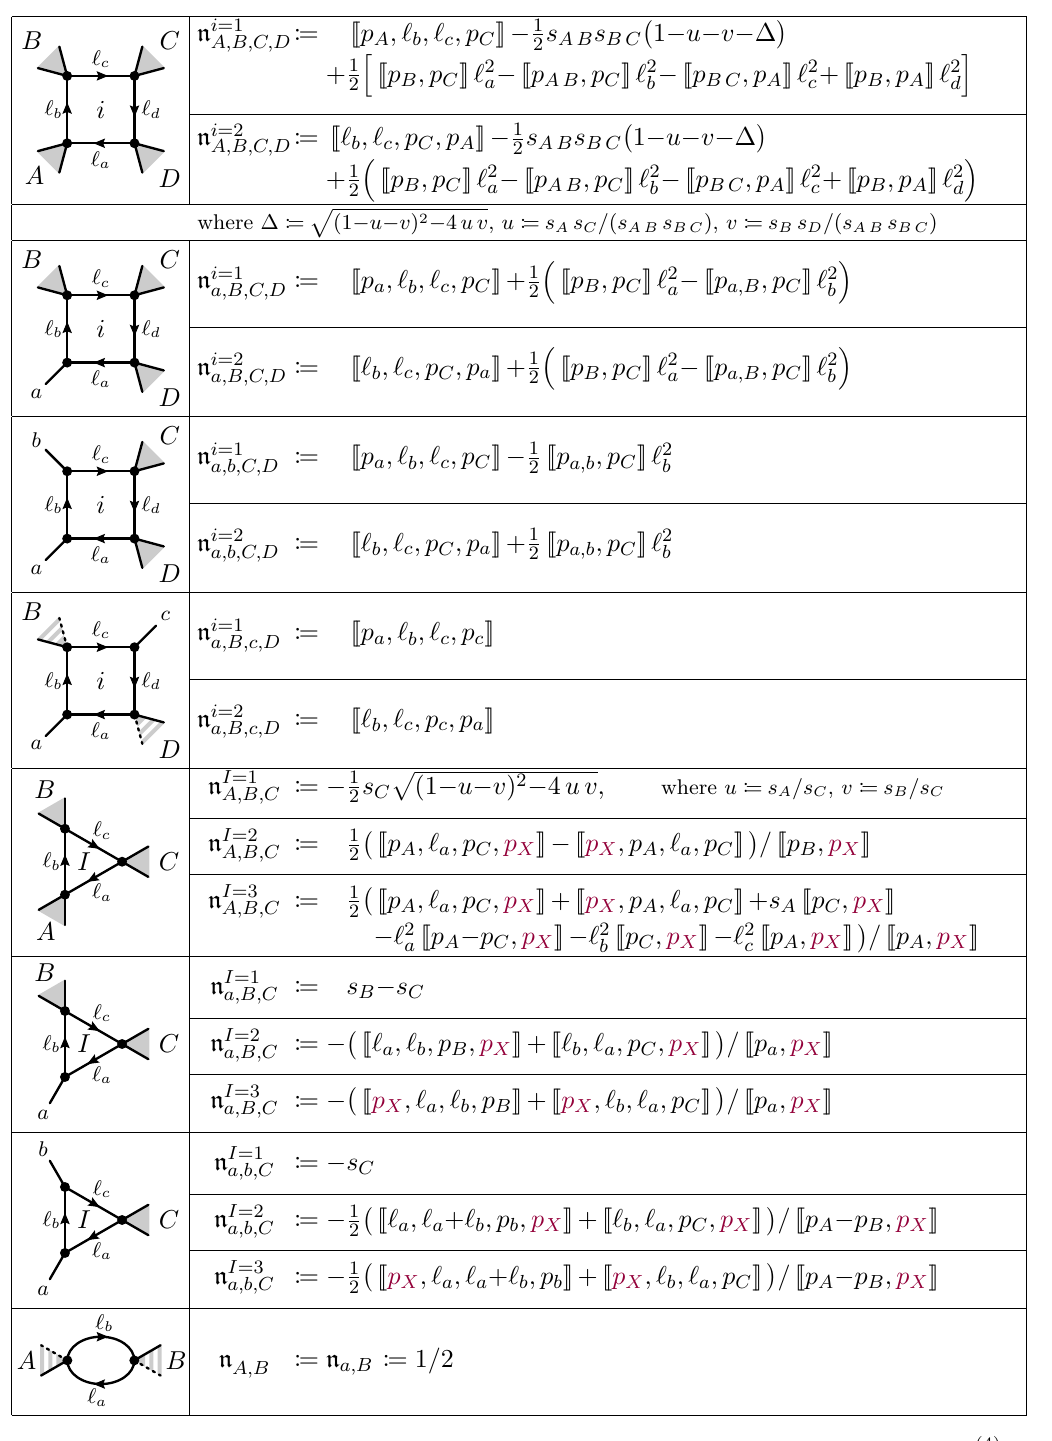
Table 4 . Basis integrand numerators for all box, triangle, and bubble integrands in B (4)